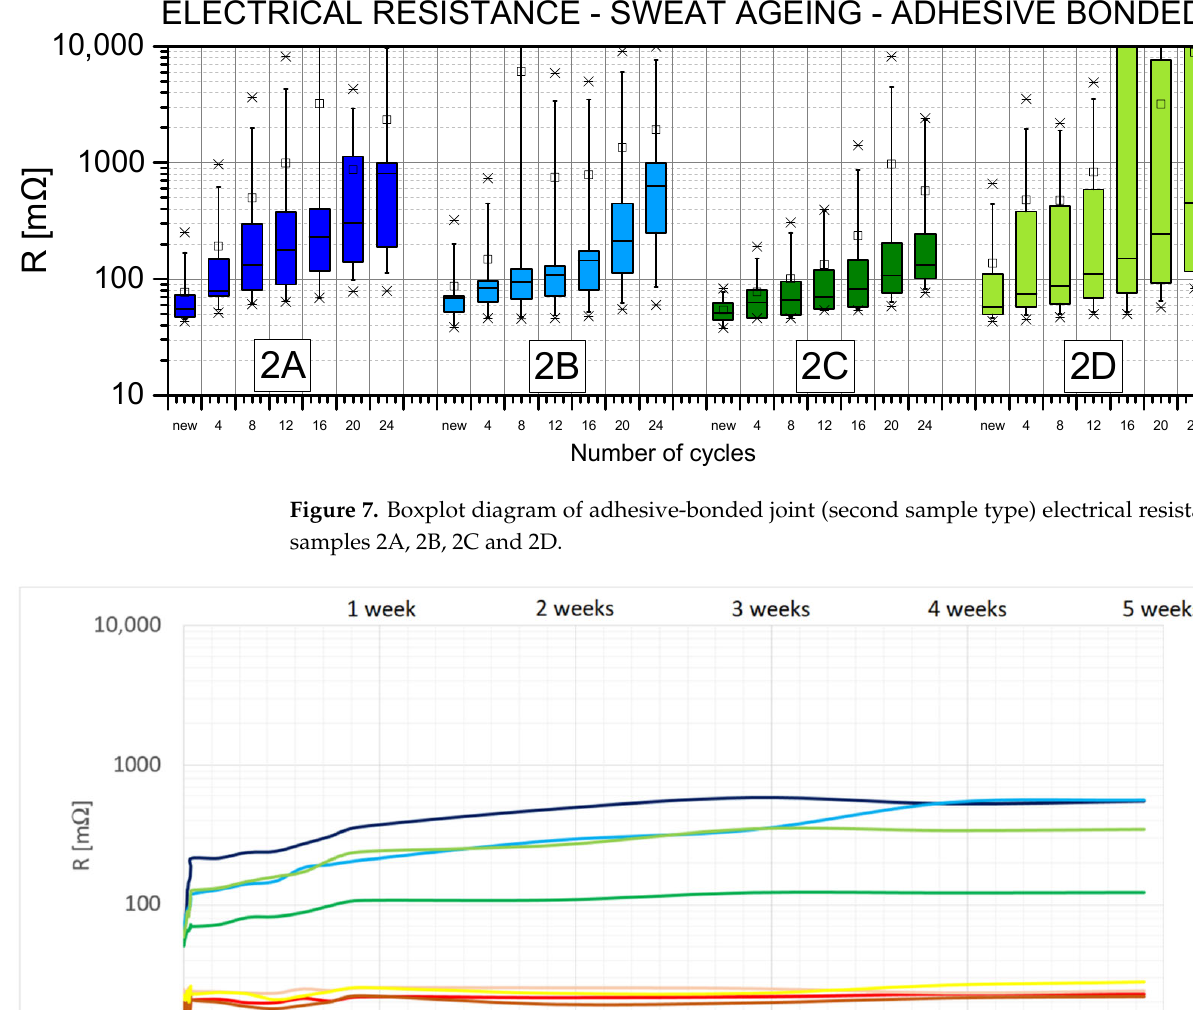
Figure 8. Medians of electrical resistance for the first (1A, 1B, 1C, 1D) and second (2A, 2B, 2C, 2D) sample types tested under sweat.